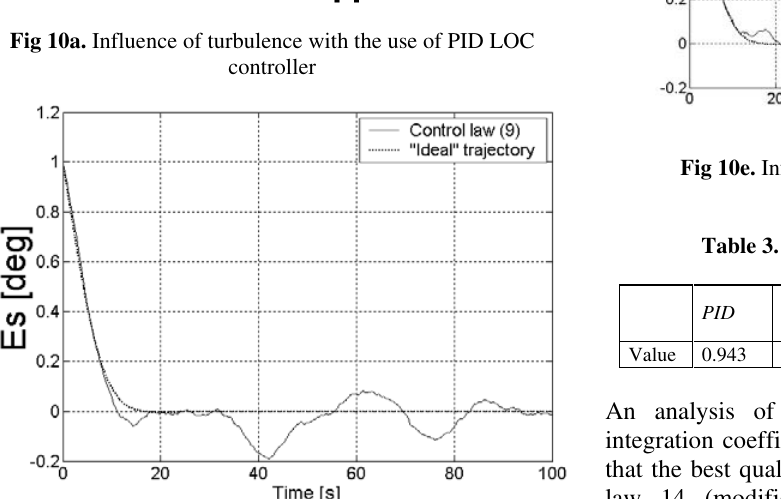
Fig 10b. Influence of turbulence with the use of control law (9)